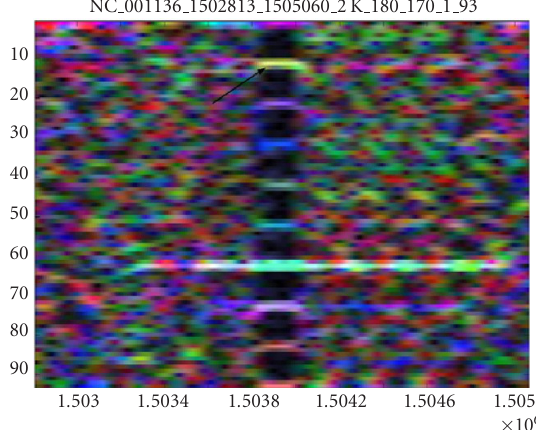
Figure 22: Spectrogram showing shaft in FIT1 gene. The arrow highlights period 18, showing an intensity corresponding to a re- peat of 6 amino acids.